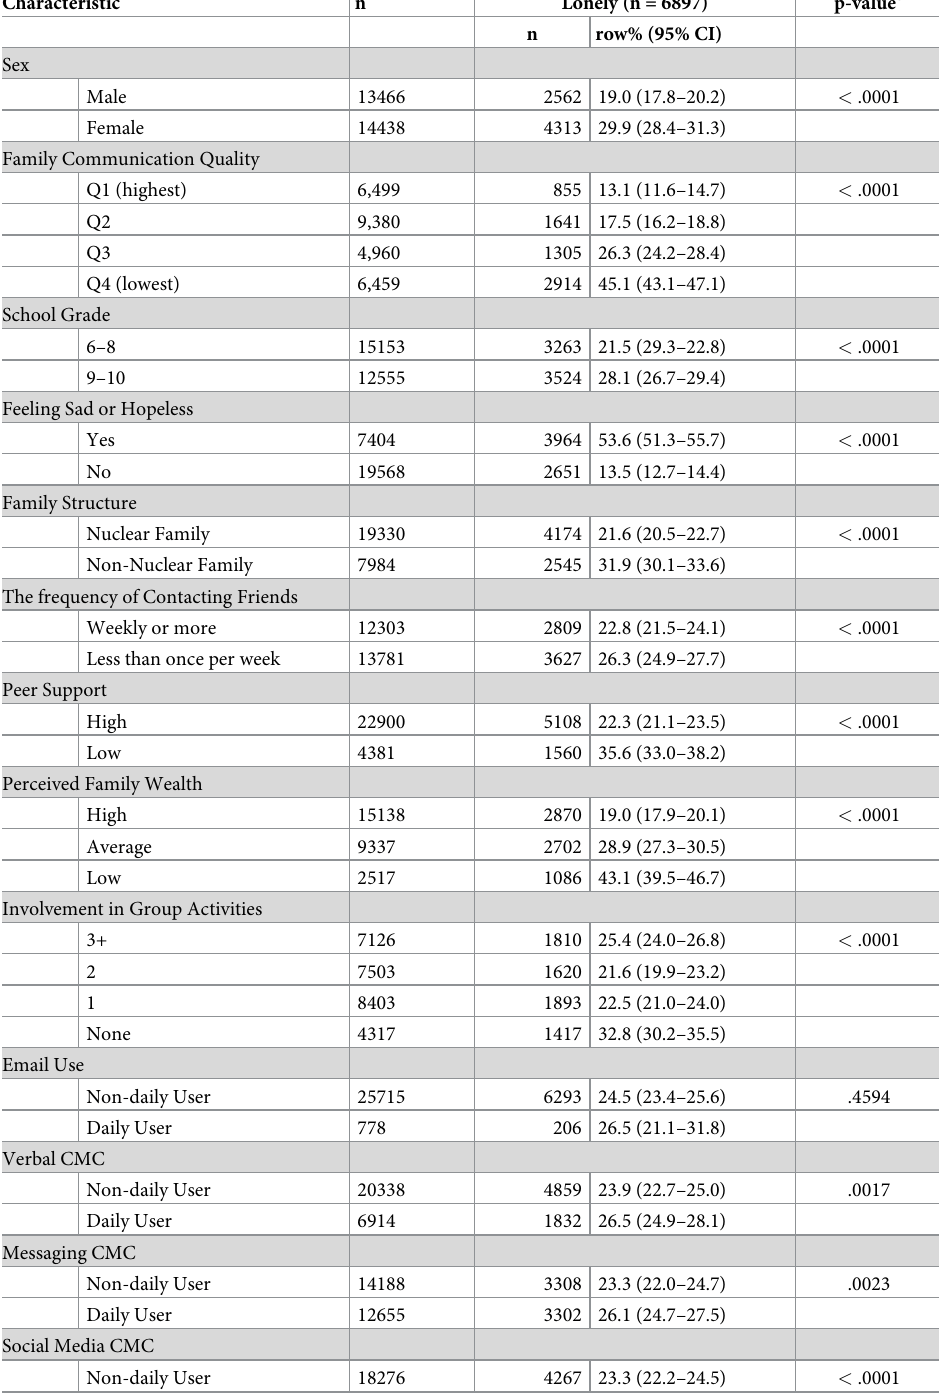
Table 2. Prevalence of loneliness by socio-demographic, family and peer characteristics (row%) a (N =